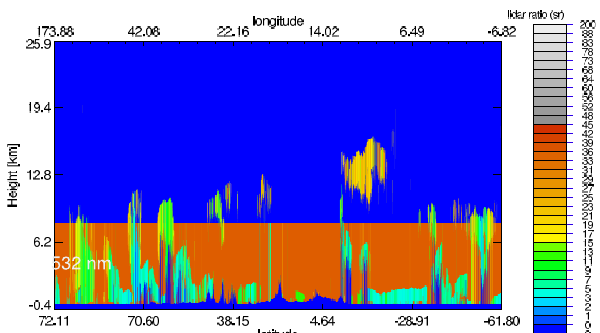
Fig. 5. Cloud and aerosol effective particle lidar ratio (sr) as ob- tained from the retrieval algorithm for the scene in the left panel of Fig. 4. Dark blue spots denote areas that are free of particles (upper troposphere, stratosphere and below the earth surface). The orange bar between the surface and 8km corresponds to the imposed de- fault 35 (sr) lidar ratio value for aerosols.